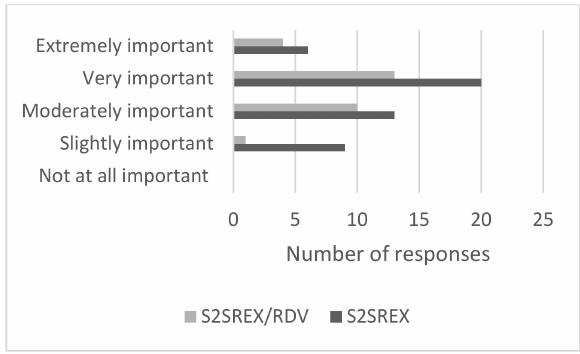
Figure 2. Perceived importance of S2SREX and S2SREX / RDV to decision